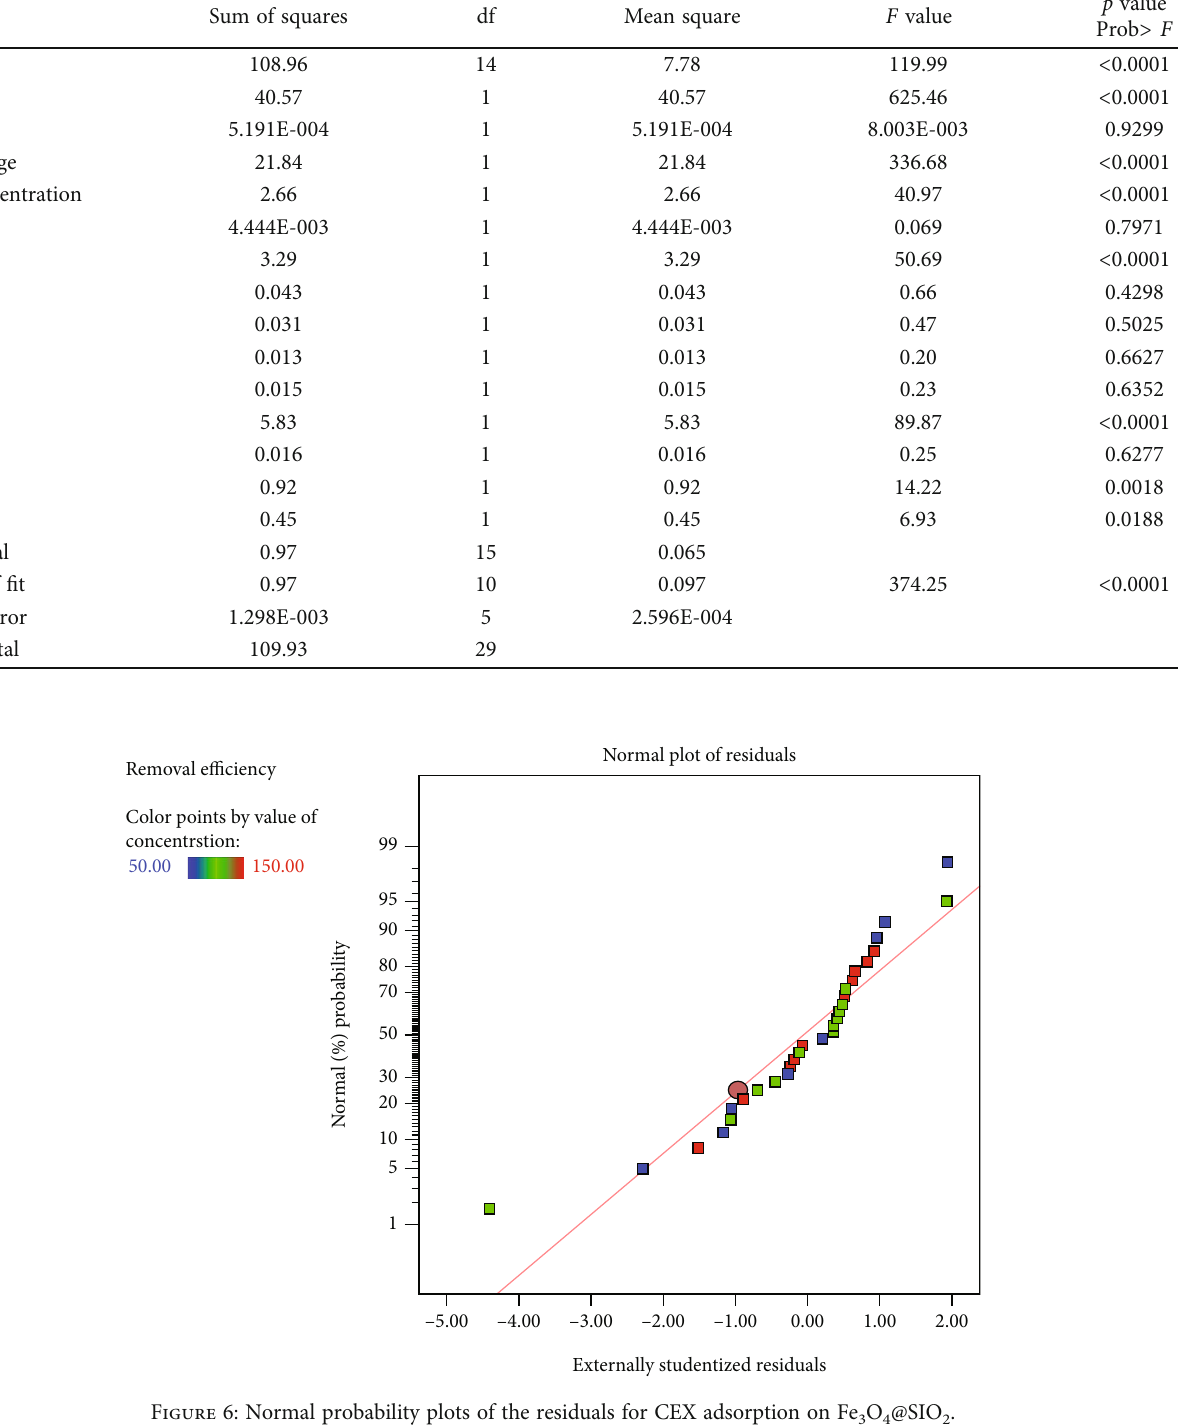
Table 7: ANOVA for the response surface quadratic model of CEX adsorption on Fe